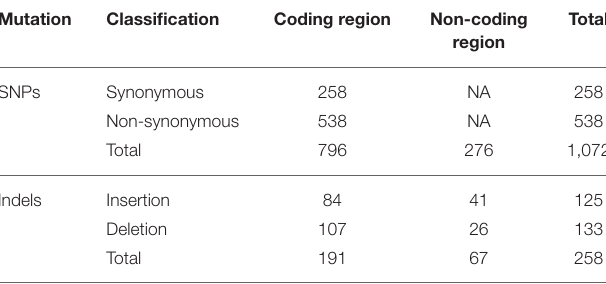
TABLE 1 | Classification and total number of identified mutations among isolates of L. interrogans serovars Copenhageni and Icterohaemorrhagiae.